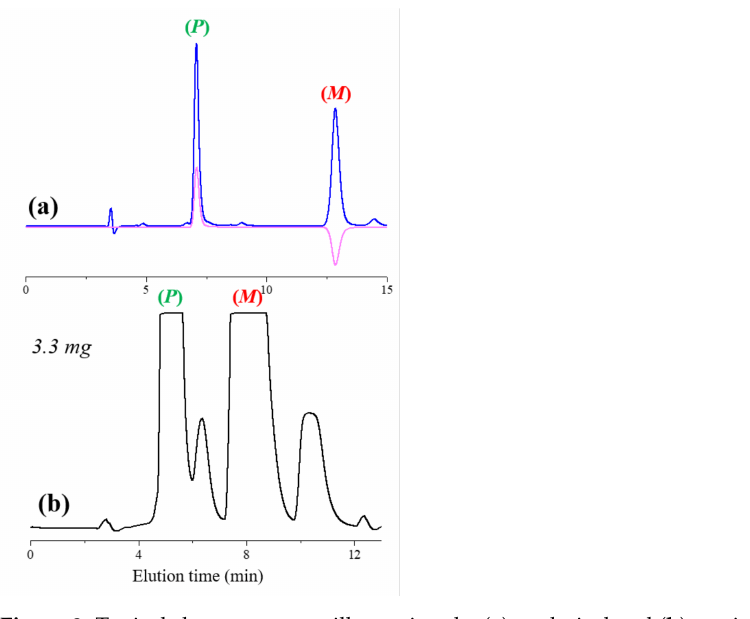
Figure 3. Typical chromatograms illustrating the ( a ) analytical and ( b ) semipreparative enantiosepa- ration of 4 . Detector, UV/CD at 330 nm ( a ) and UV at 330 nm ( b ).